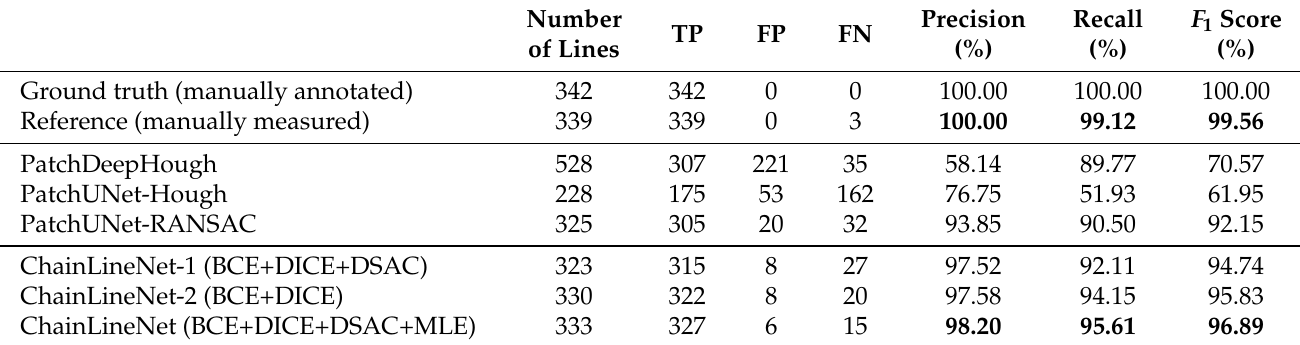
Table 2. Evaluation of precision, recall, and the F 1 score of chain line detection for the test set with 48 images. The number of true positives (TP), false positives (FP), and false negatives (FN) are determined based on a distance threshold of 50 pixels between the predicted and ground truth lines. Best scores are highlighted in bold.